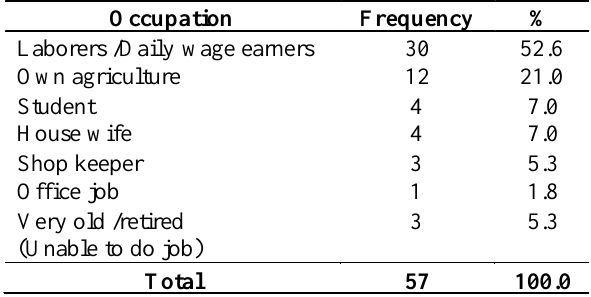
Table III: Main occupation of the sample study population (Non-compliant cases)